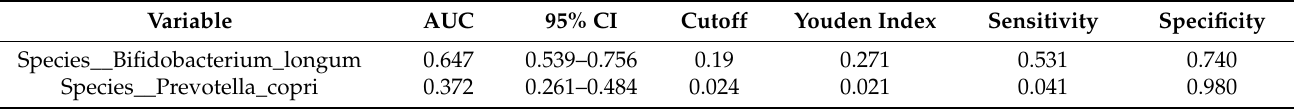
Table 4. Results of ROC